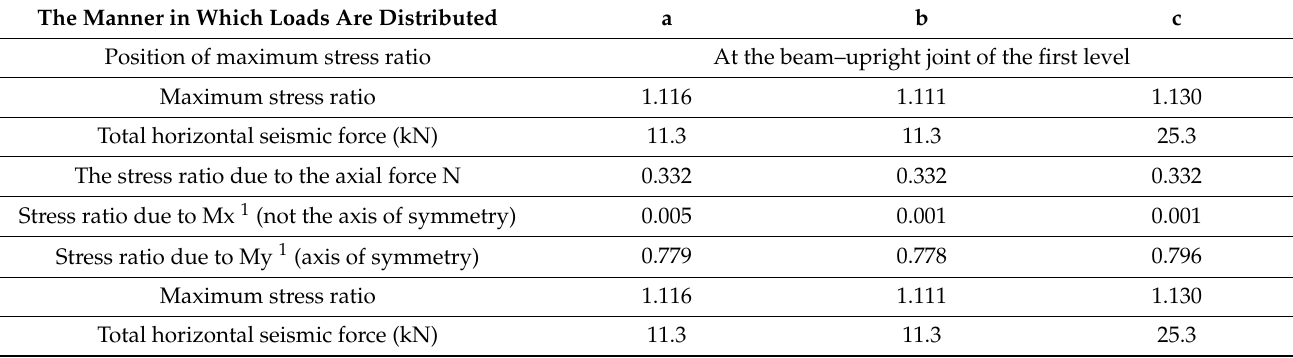
Table 7. Relations between the distribution mode of load and the stress of the